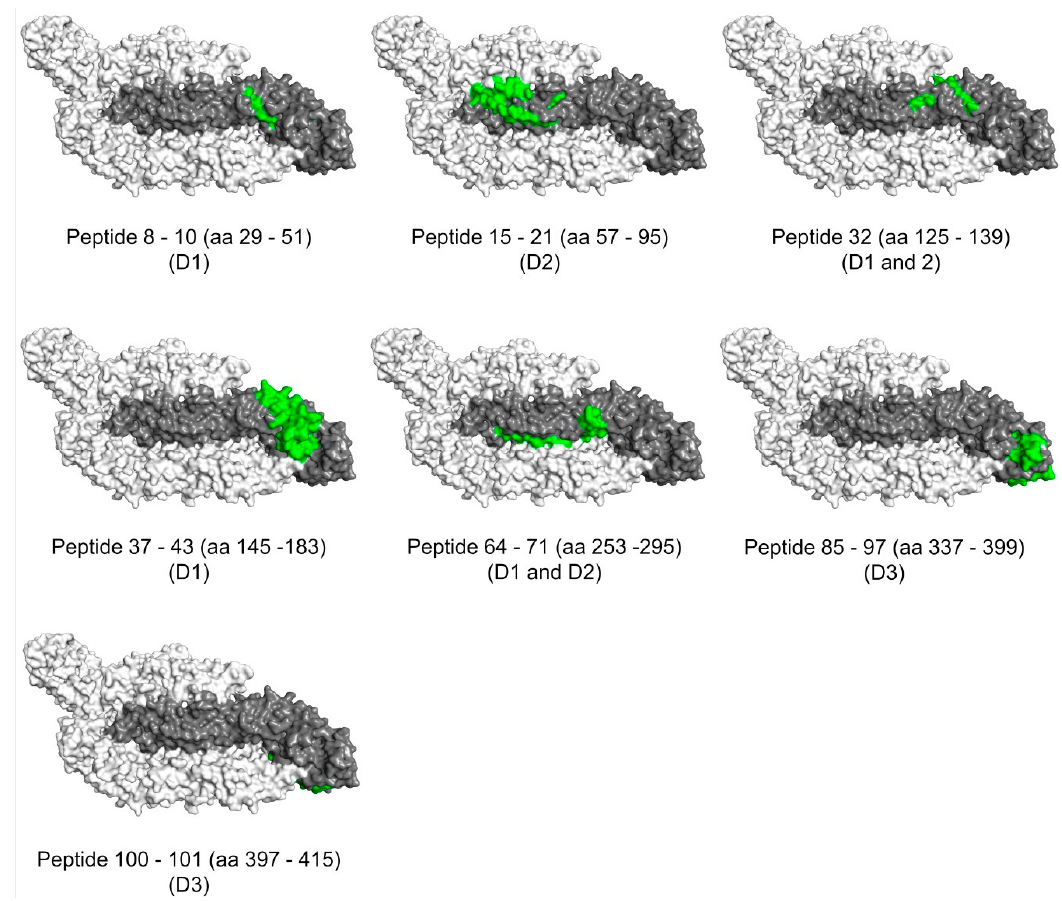
Figure 7. Surface exposure of the binding sites. The residues which are included in each of the defined binding sites of the purified antibodies (K45–K90) are highlighted in green on the surface representation (looking from outside the virion) of the ZIKV E protein structure [modified from PDB ID: 5IRE]. The binding sites with the corresponding amino acid number and the E domain are indicated below each representation. In each representation, single ZIKV E monomer is shown in gray and the surrounding two E monomers are shown in white.